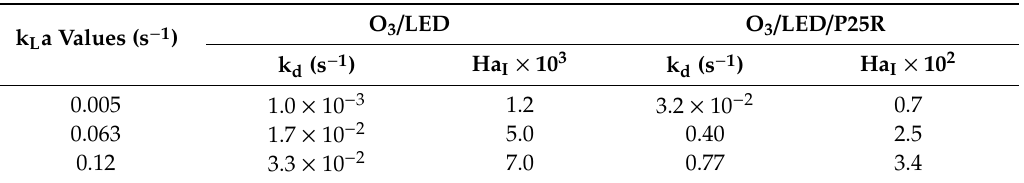
Table 4. Apparent pseudo first order rate constant and Hatta number (Ha) values for ozone decomposition in water in the presence of radiation and radiation/P25R.